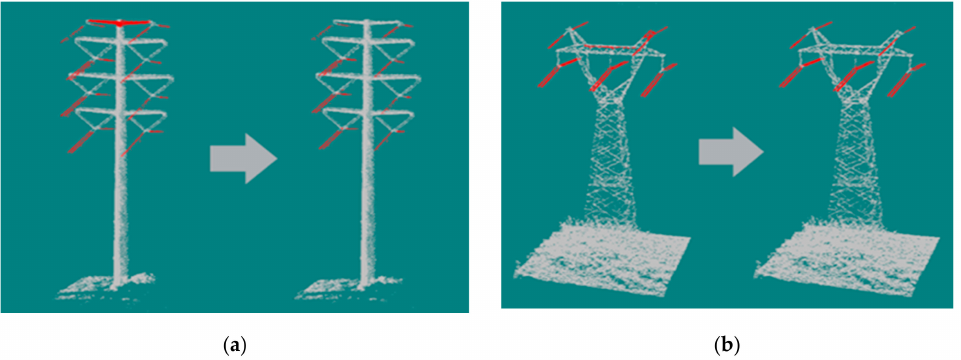
Figure 8. The optimization effect of the adaptive entropy weights switching. ( a ) The extraction results before and after adaptive weights with a steel pipe tower; ( b ) the extraction results before and after adaptive weights with a cat-head